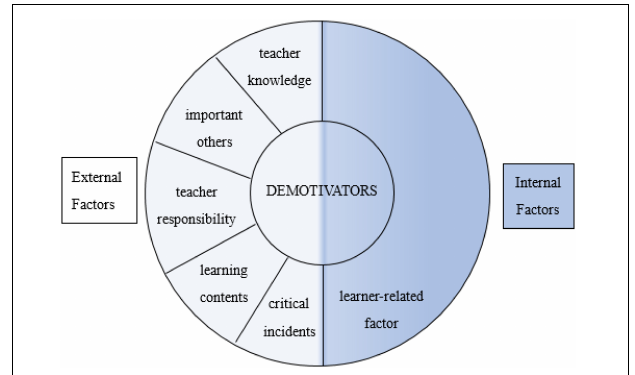
FIGURE 1 | Classification of the demotivators.